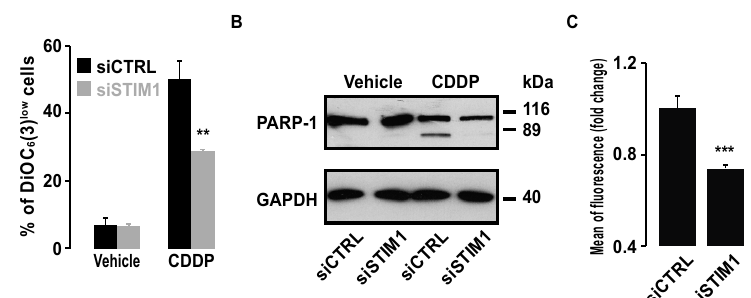
Figure 9. Effect of STIM1 depletion on CDDP-induced cell death and ROS production in HeLa cells. ( A ) Bar histogram showing the percentage of cells with low ΔΨ m in the presence of 25 µM CDDP in siCTRL or siSTIM1 transfected HeLa cells. Data are means of three experiments ± S.D. Student’s t test was employed to assess statistical significance. ** p < 0.01. ( B ) Immunoblot analysis showing the effect of 24 h treatment with 25 µM CDDP on PARP-1 cleavage in siCTRL or siSTIM1 transfected cells. GAPDH was used as a loading control. ( C ) Bar histogram showing the mean level of fluorescence emitted by the H2DCFDA probe allowing ROS production assessment in the presence of 25 µM CDDP in siCTRL or siSTIM1 transfected HeLa cells. Data are means of three experiments ± S.D. Student’s t test was employed to assess statistical significance. *** p < 0.001.